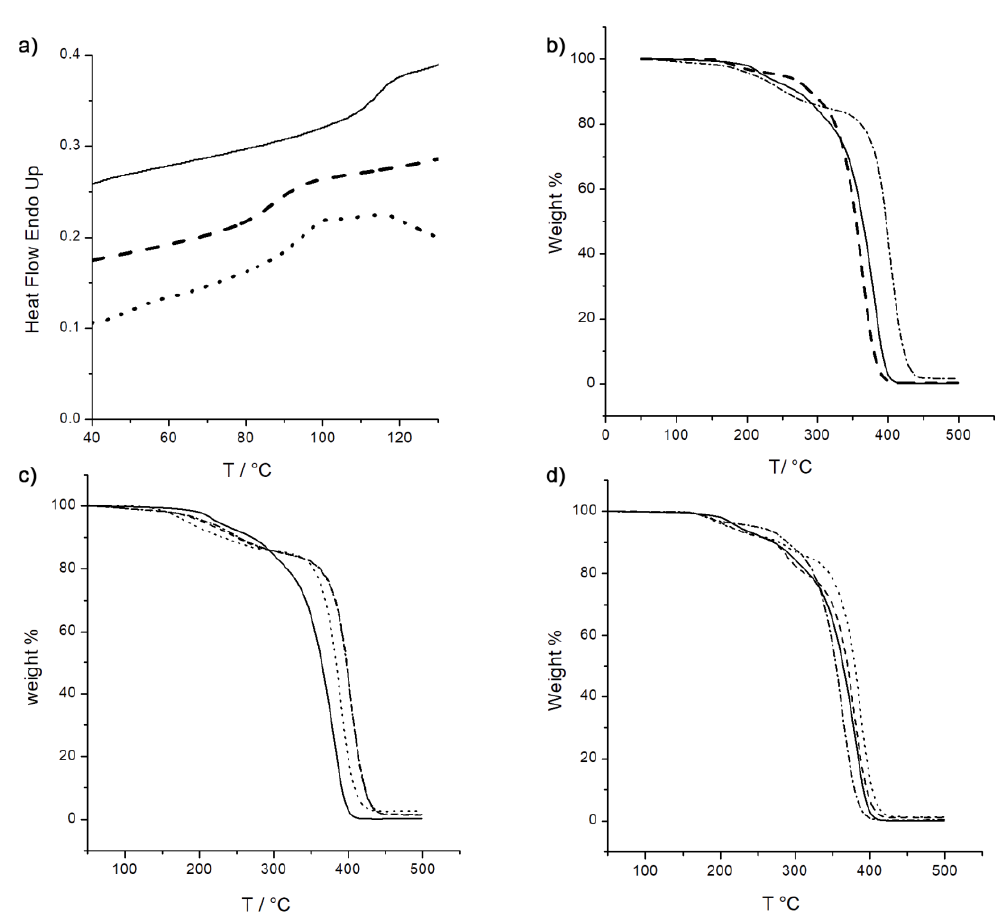
Figure 3. Thermal behavior of PMMA and PMMA composited loaded with 3% of Ta 6 cluster unit. ( a ) DSC thermograms of PMMA (solid), Ta_3@PMMA brown (dash) and Ta_3@PMMA green (dot), ( b ) TGA curves of PMMA (solid), Ta_3@PMMA brown (dash) and Ta_3@PMMA green (dash-dot), ( c ) TGA of reduced Ta_x@PMMA green of PMMA (solid), Ta_1@PMMA green (dash), Ta_2@PMMA green dot and Ta_3@PMMA green (dash-dot) and ( d ) TGA of oxidized Ta_x@PMMA brown of PMMA (solid), Ta_1@PMMA brown (dash), Ta_2@PMMA brown dot and Ta_3@PMMA brown (dash-dot).